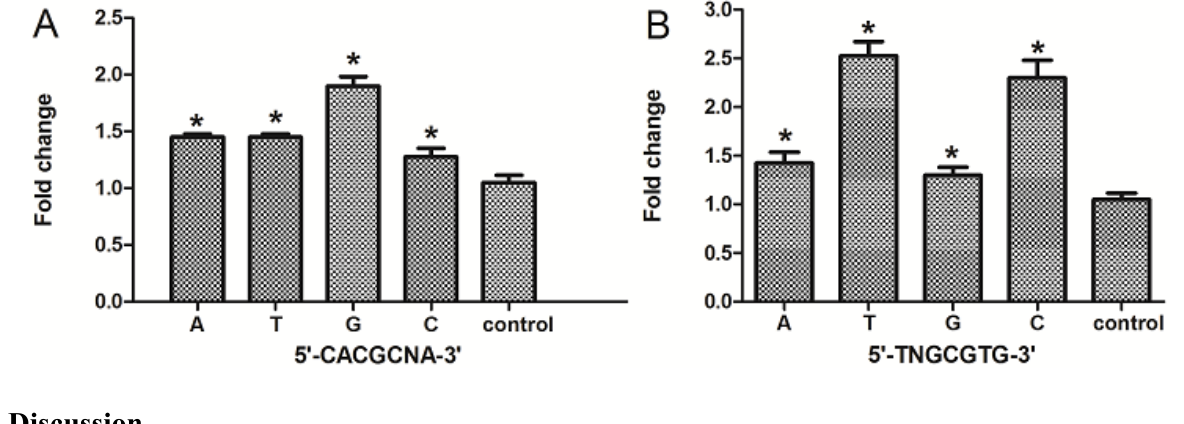
Figure 5. The nucleotide “N” in the core DRE (5'-TNGCGTG-3') sequence contributed to the AhR-dependent transcriptional differences. The mouse CYP1A1 promoter-reporter constructs, which contain “N” mutations of the DRE sequence at position -488 (5'-CACGCGA-3') ( A ) or which contain “N” mutations of the reversed 25-bp DRE sequence at position, -488 (5'-TCGCGTG-3') ( B ) were transiently transfected into cultured Hepa WT cells one day before drug treatment. The pGL3-basic vector is used as the control. After one day of treatment, luciferase assays were performed to determine the promoter activity of mouse CYP1A1. The transfected cells were incubated with TCDD (10 − 9 M) or with solvent alone at 0.1% (control). * p < 0.05, the difference from solvent-treated cells (control) by one-way ANOVA with Tukey’s